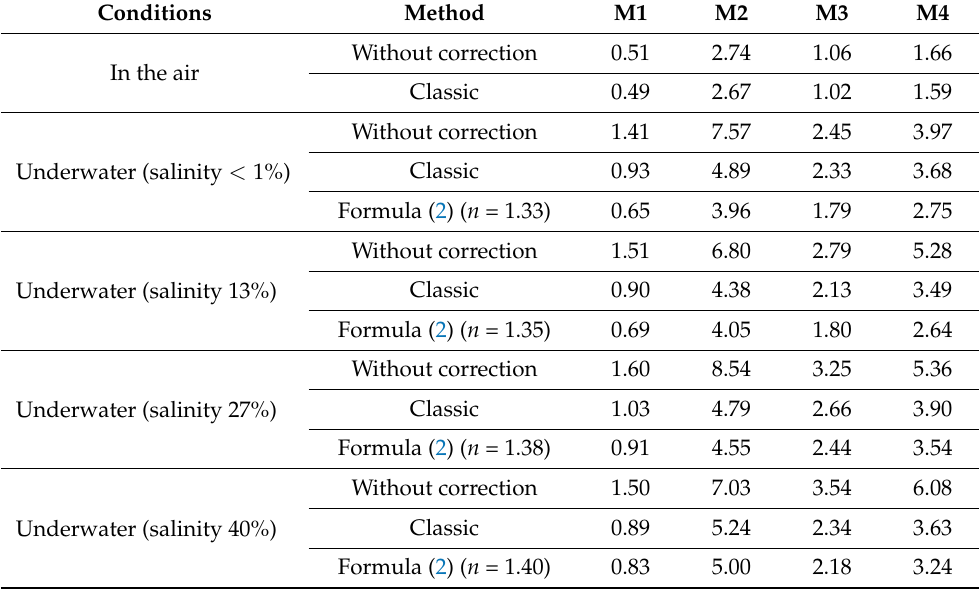
Table 1. Comparison of the precision of radial distortion correction using the classical method and Formula